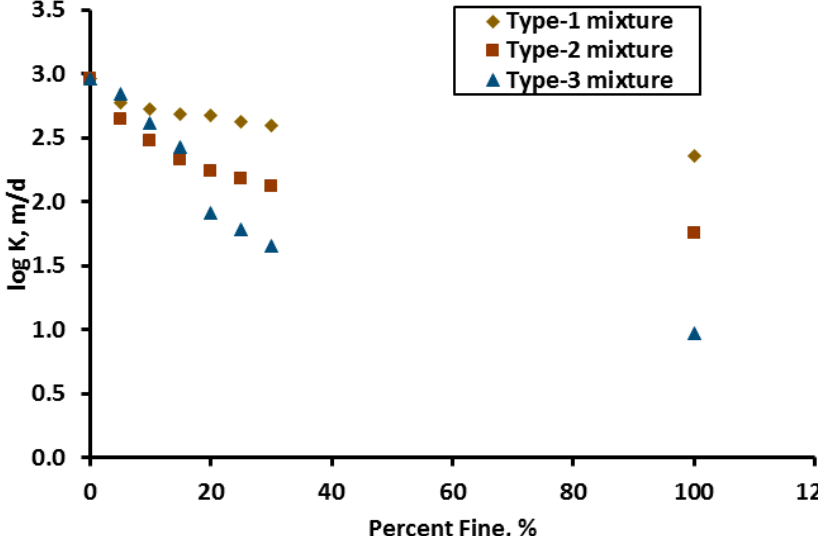
Figure 2. Decrease in the effective hydraulic conductivity values (K values plotted in log scale) of Type-1 (K c = 920 m/day and K f = 228 m/day), Type-2 (K c = 920 m/day and K f = 57 m/day), and Type-3 (K c = 920 m/day and K f = 9 m/day) coarse-fine mixtures. The seven mixtures for each type were prepared by varying the fine porous media content (percentage by weight) as: 0%, 5%, 10%, 15%, 20%, 25%, and 30%.